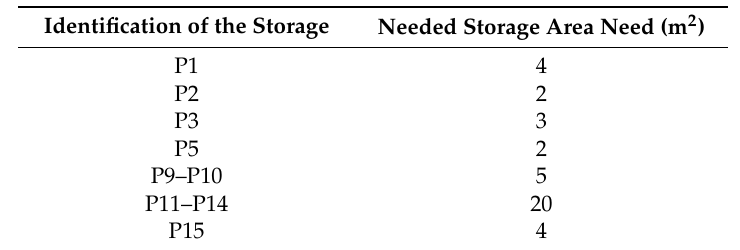
Table 12. Needed storage area.